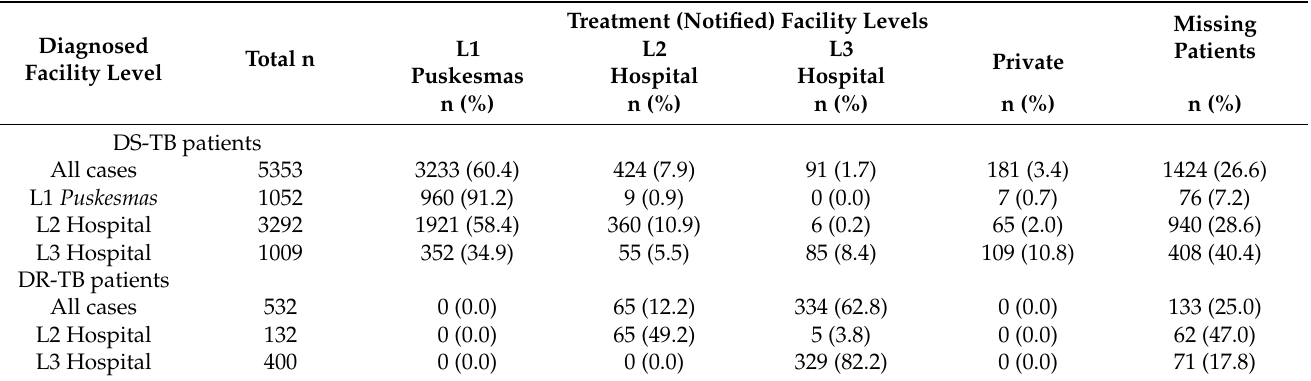
Table 3. Cascade of confirmed DS- and DR-TB patients from the diagnosed facility level to the treatment registers in the provinces of North Sumatra and West Sumatra between 2017 and